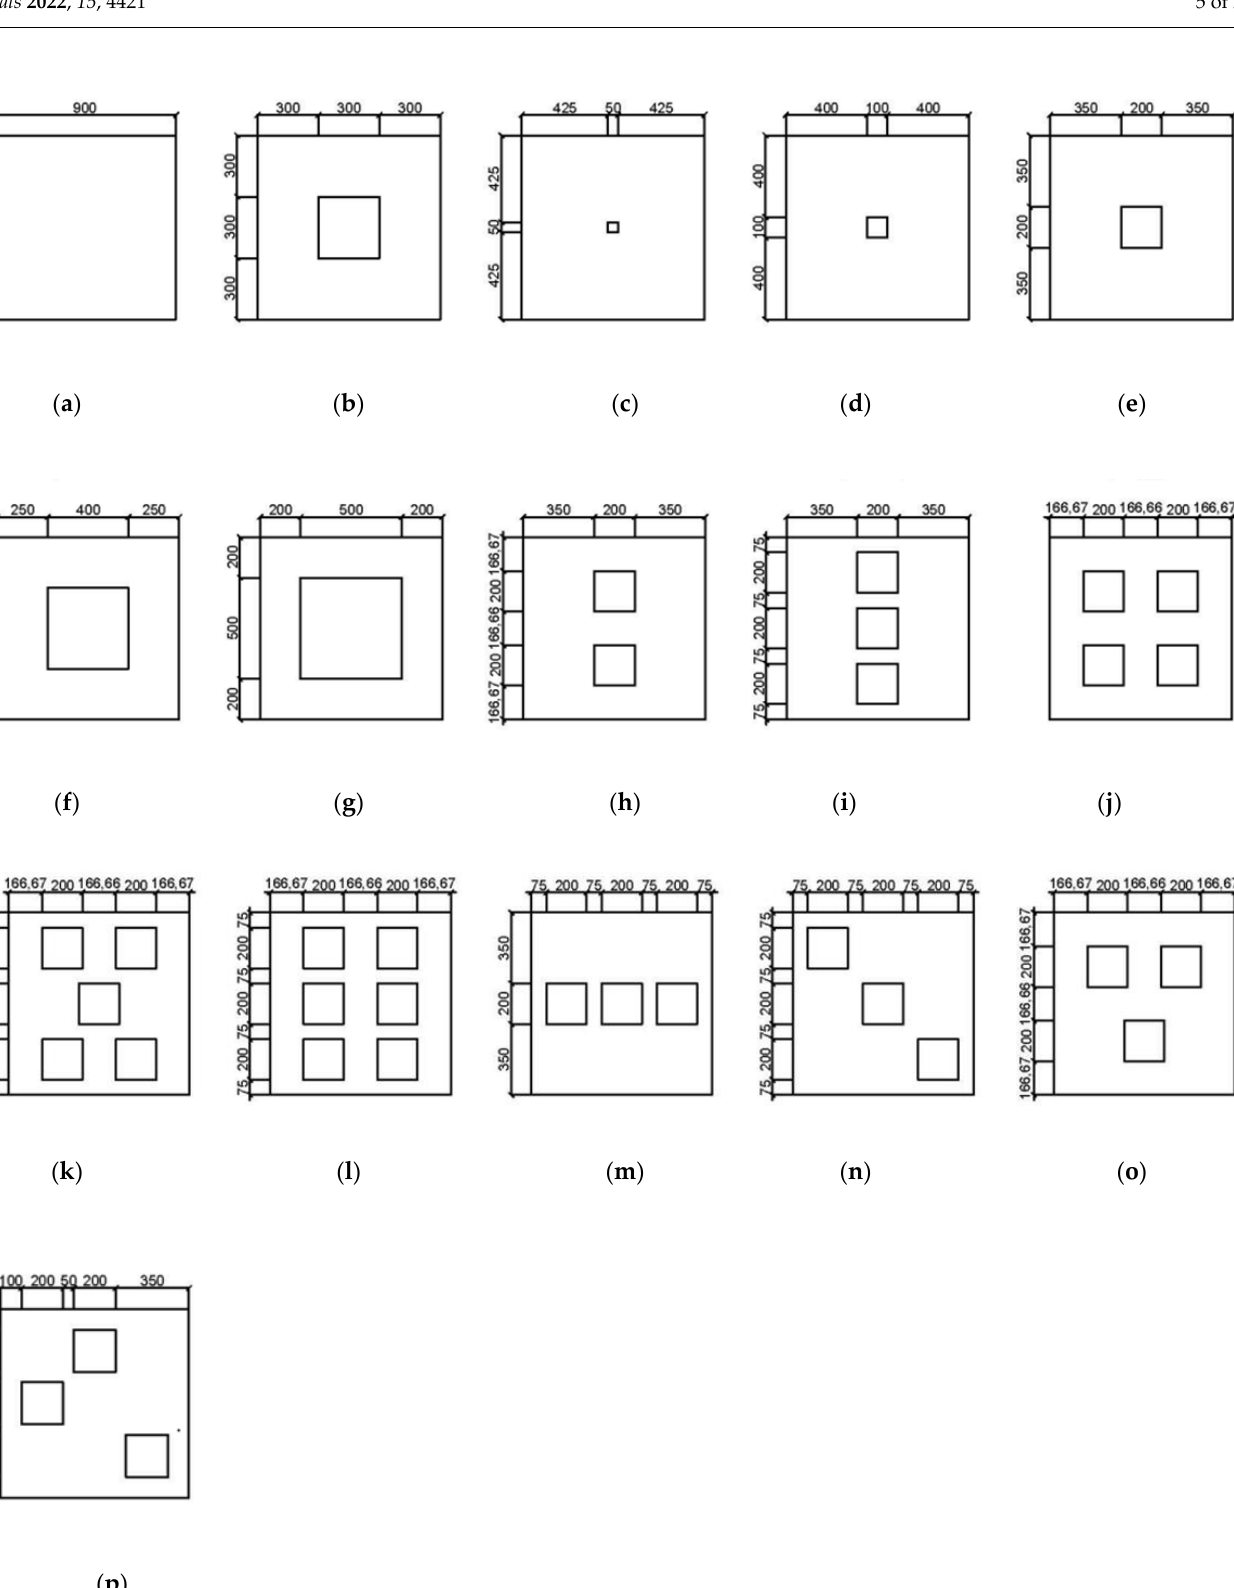
Figure 2. Visual schematics of the modelled specimens. ( a ) S1; ( b ) S2, S3, S4, S5 & S6; ( c ) S7; ( d ) S8;